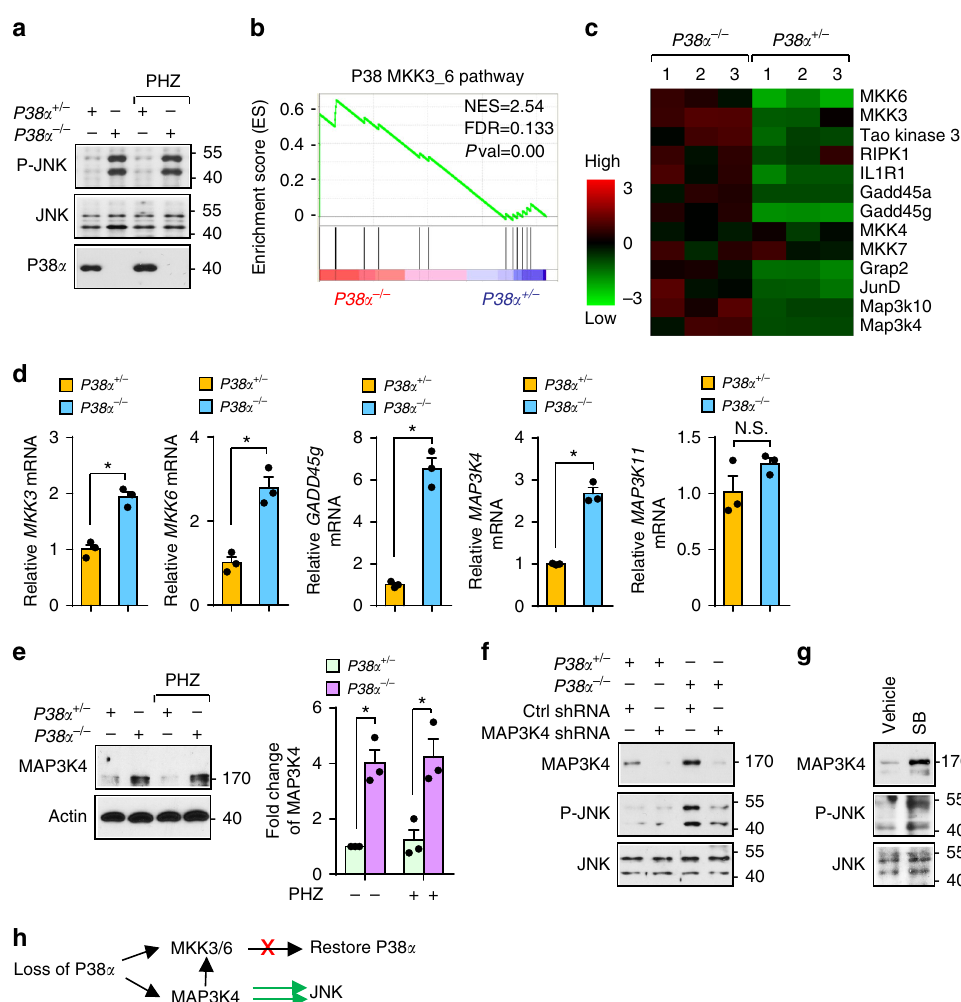
Fig. 2 Upregulated Map3k4 due to P38 α de fi ciency mediates JNK activation in erythroblasts. a In sorted erythroblasts from P38 α + / − and P38 α − / − mice, phosphorylated JNK (46 and 54 kDa) was detected by immunoblotting. b Gene set enrichment analysis (GSEA) of the P38 pathway based on gene expression pro fi ling of sorted CD71 high Ter119 + erythroblasts from P38 α + / − and P38 α − / − mice during recovery from PHZ challenge. NES normalized enrichment score; FDR false discovery rate q -value. c Heat map of P38 α -related genes. d mRNA levels of key P38 and JNK regulatory genes in sorted P38 α + / − and P38 α − / − CD71 high Ter119 + erythroblasts by q-PCR. e Western blot (left) and densitometry analysis (right) of Map3k4 protein level in P38 α + / − and P38 α − / − erythroblasts. Data are shown as mean ± s.e.m from three separate experiments. f Sorted GFP + P38 α + / − and P38 α − / − cells transduced with control or Map3k4-speci fi c shRNA. Expression of phosphorylated JNK and Map3k4 as assessed by immunoblotting. g Expression of phosphorylated JNK and Map3k4 in human erythroblasts cultured with DMSO or SB203580. h Schematic diagram demonstrating mechanism by which loss of P38 α rewires increased Map3k4 to exclusively activate JNK. Blots are representative of three independent experiments. Data are shown as mean